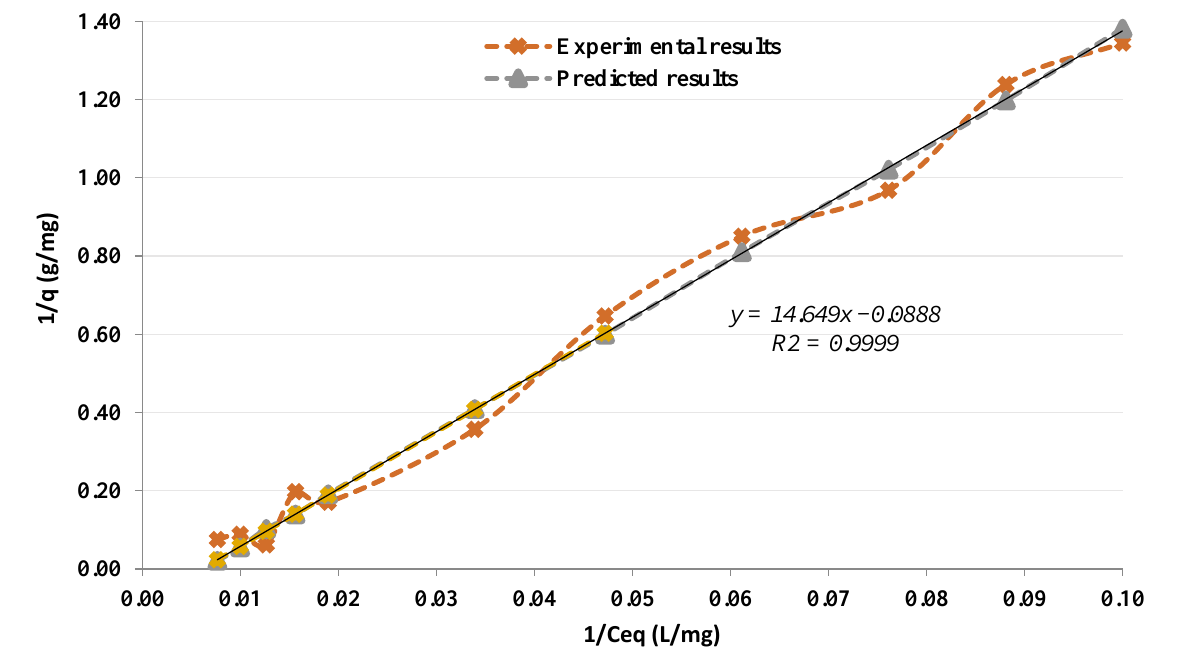
Figure 4. Reciprocal of the adsorption isotherm plot (1/ q e versus 1/ C eq ).